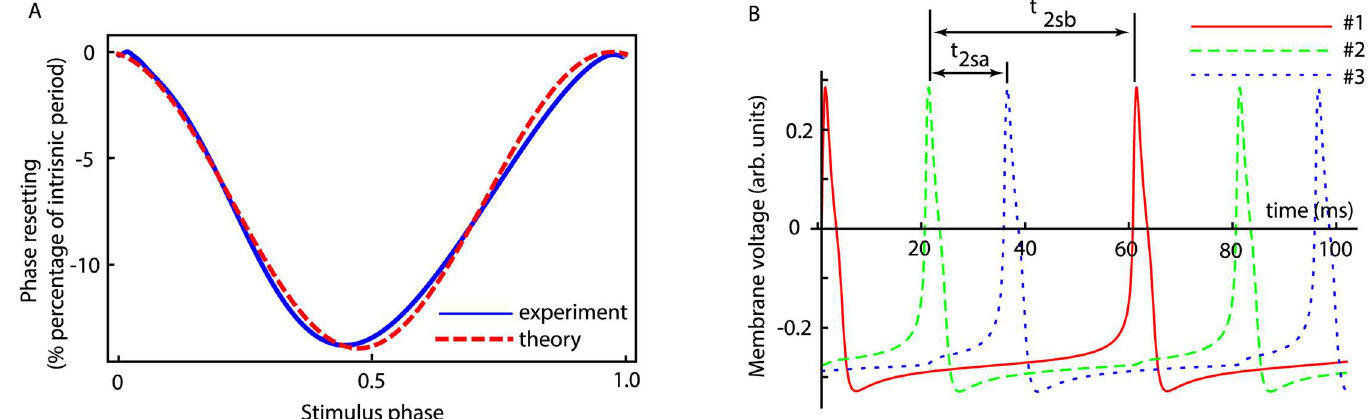
Fig 6. Phase-locked modes in fully coupled neural network. ( A ) The numerically generatedPRC in open loop setup in responseto a single triangularly shapedstimulus (solid circles) was fitted to the theoretical PRC given by Eq (17) to determined the conversionfactor betweenthe model-dependent coupling constant c in Eq (17) and the synapticcoupling g syn . ( B ) A typical stable phase locked mode in which neuron#2 (dashedline) receives two inputs duringa single cycle: first from neuron#3 (dotted line) at t (cid:3) and then from neuron#1 (continuousline) at t (cid:3) . The experimental values for the phase locked mode as 2 sa 2 sb ¼ 15 : 2 ms and t (cid:3) ¼ 40 : 2 ms whereasthe PRC-basedpredictions were t (cid:3) ¼ 18 : 0 ms and t (cid:3) ¼ 44 : 1 ms. The network’s measuredfrom panel ( B ) were t (cid:3) 2 sa 2 sb 2 sa 2 sb firing periodwas P = 60 ms = P 1 i